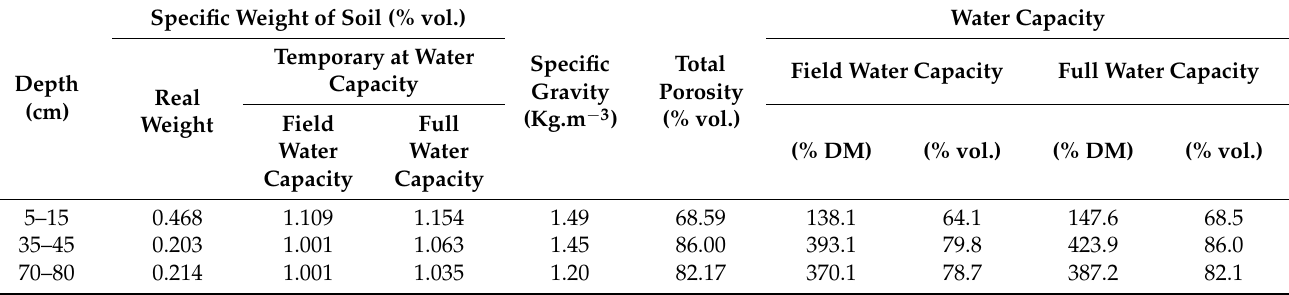
Table 4. Physical characteristics of soil prior to the establishment experiment with reseeding T.